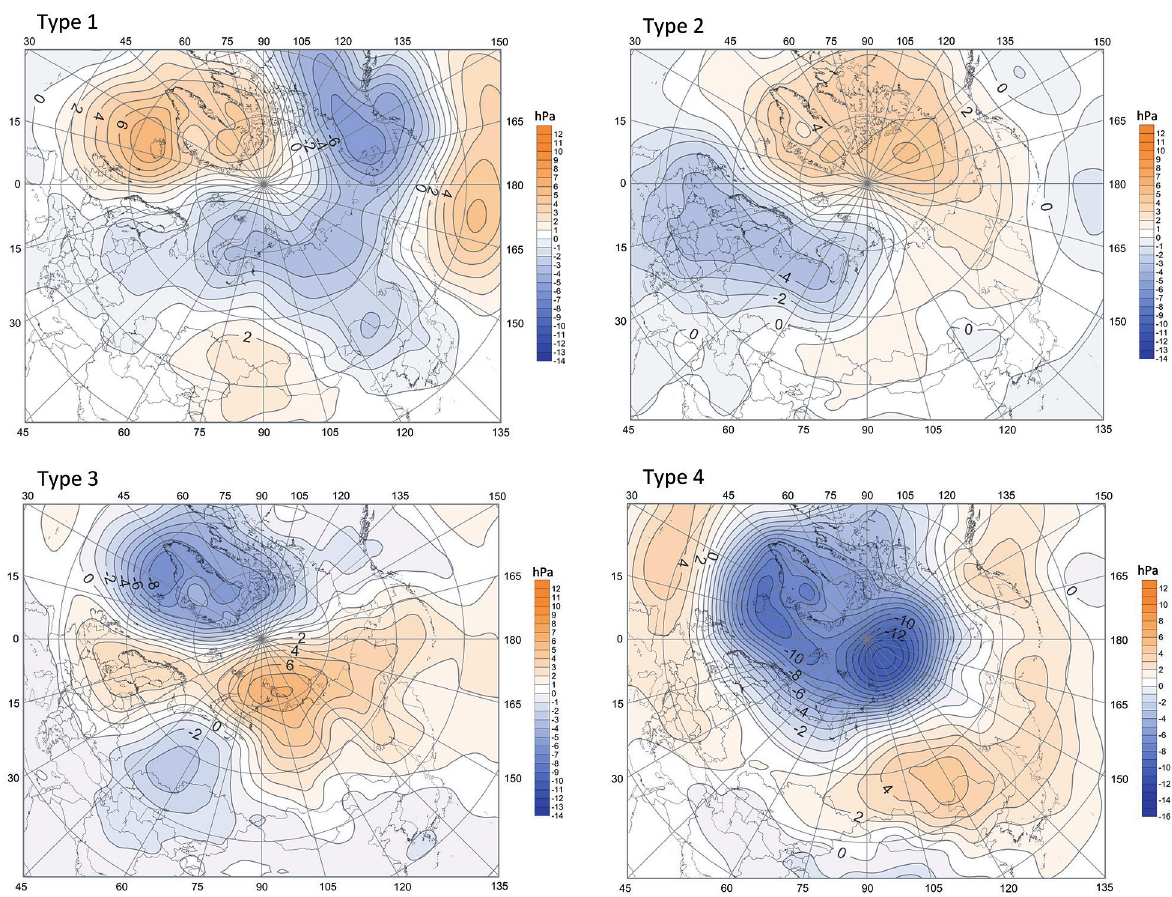
Fig. 8. SLP anomalies for circulation types distinguished for the days with intensive